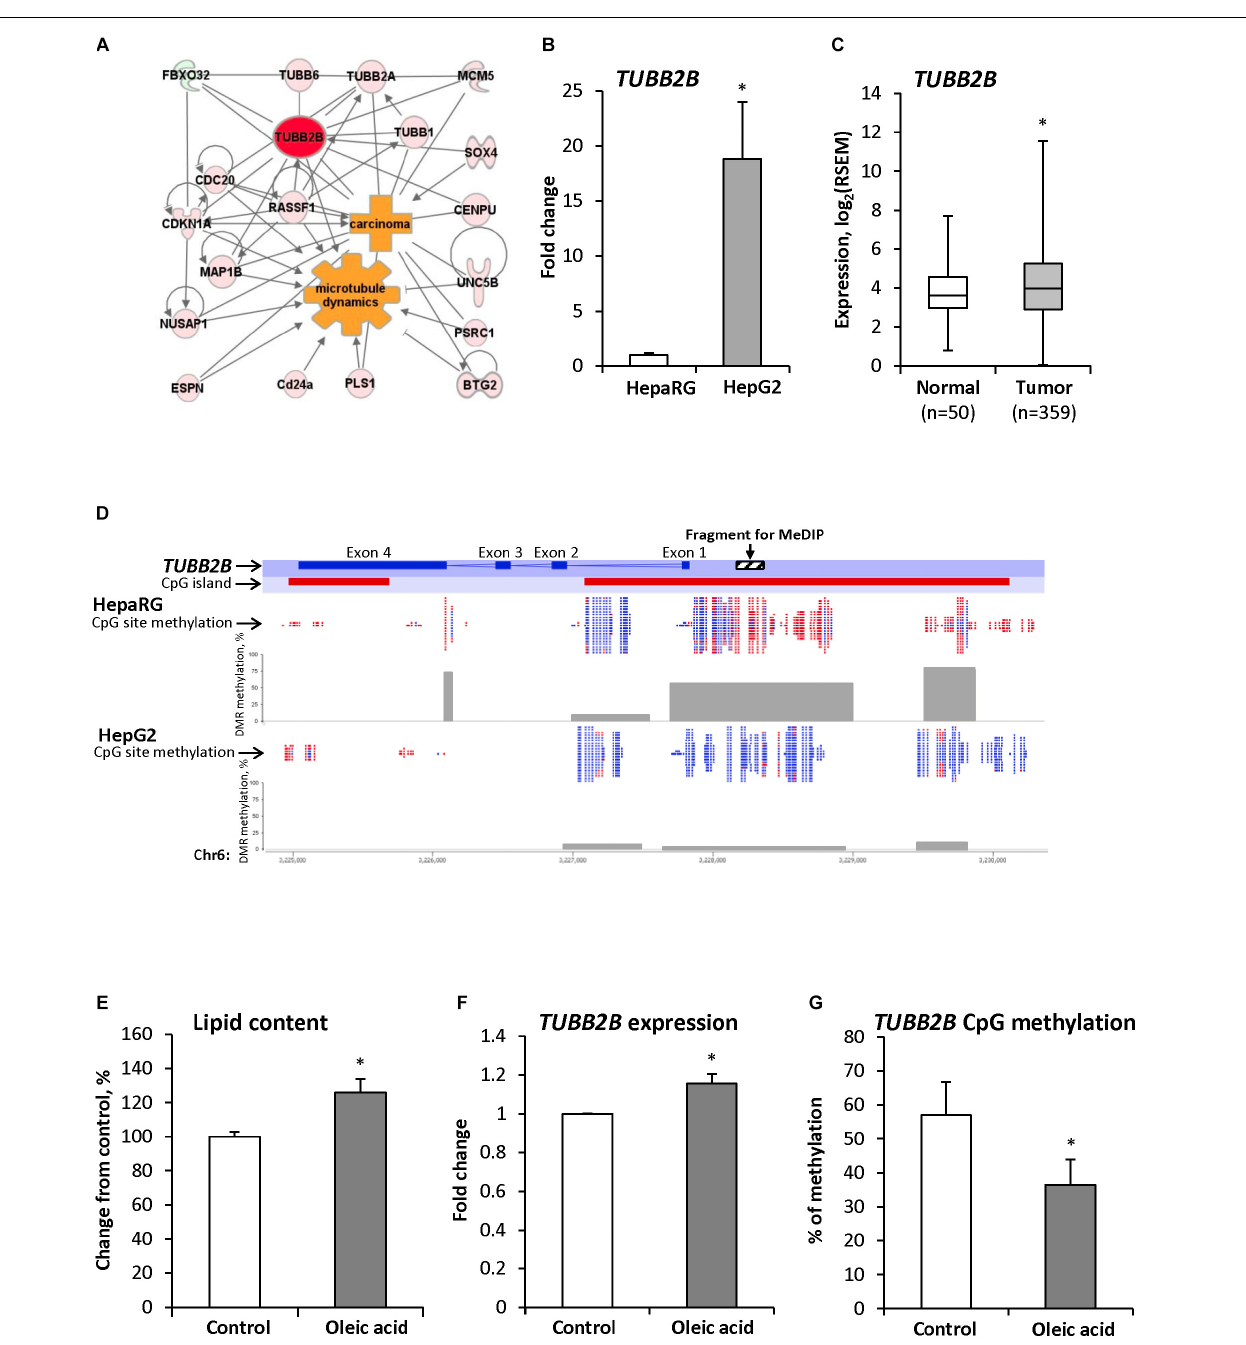
FIGURE 3 | TUBB2B gene expression and methylation aberrations during hepatocarcinogenesis. (A) Molecular network of differentially expressed genes associated with Tubb2b and microtubule dynamics in HCC of mice subjected to STAM hepatocarcinogenesis. Red color indicates up-regulated genes and green color indicates down-regulated genes. (B) Expression of the TUBB2B gene in non-tumorigenic liver HepaRG cells and human HepG2 hepatocarcinoma cells. The TUBB2B gene expression is presented as an average fold change in HepG2 cells relative to that in the fully differentiated HepaRG cells, which was assigned value 1. (C) Expression of the TUBB2B gene in human HCC samples. (D) RRBS analysis of DNA methylation in the TUBB2B gene promoter region in HepaRG and HepG2 cells. Red color indicates methylated CpG sites and blue color indicates unmethylated CpG sites. Gray boxes indicate percent of methylated CpG sites from total number of CpG sites in the differentially methylated regions (DMR). (E) The level of triglycerides in the fully differentiated human hepatic HepaRG cells after culturing cells the presence of 250 µ M oleic acid for 14 days. (F,G) Expression and promoter DNA methylation of the TUBB2B gene in fully differentiated HepaRG cells after culturing cells in the presence of 250 µ M oleic acid for 14 days. The TUBB2B gene expression is presented as an average fold change in the HepaRG cells treated with oleic acid relative to the gene expression in non-treated HepaRG cells, which was assigned value 1. Values are mean ± SD, n = 3. ∗ Denotes statistically a significant ( P < 0.05) difference of gene expression and promoter DNA